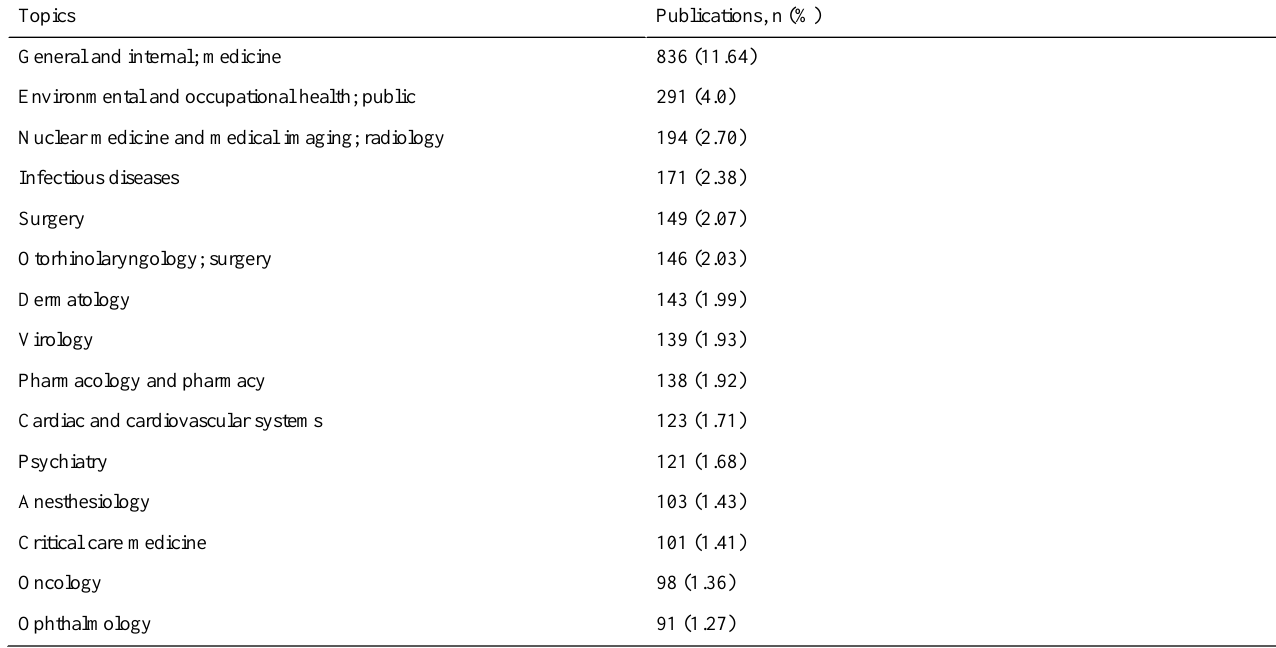
Table 1. Research categories of publications matched to their respective